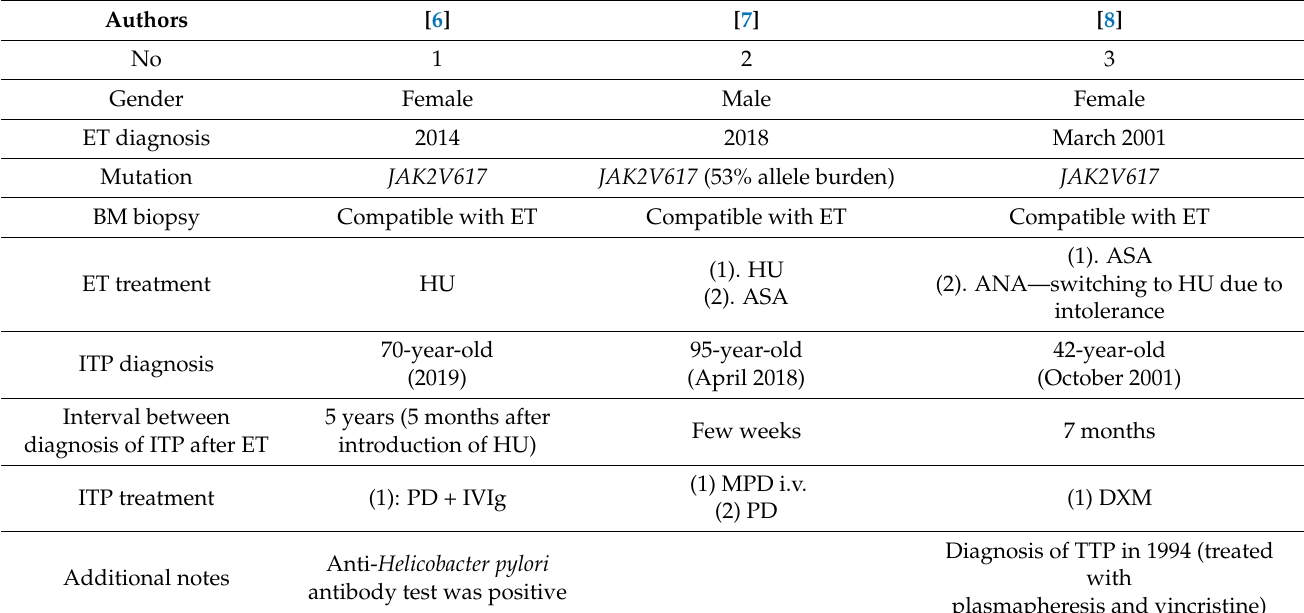
Table 2. Primary immune thrombocytopenia (ITP) following essential thrombocythemia (ET), Bone marrow (BM)